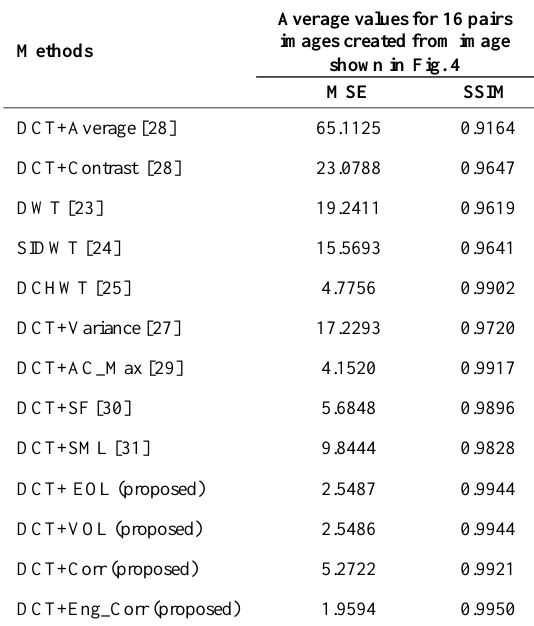
Table 1. MSE and SSIM comparison of various image fusion methods on reference images.